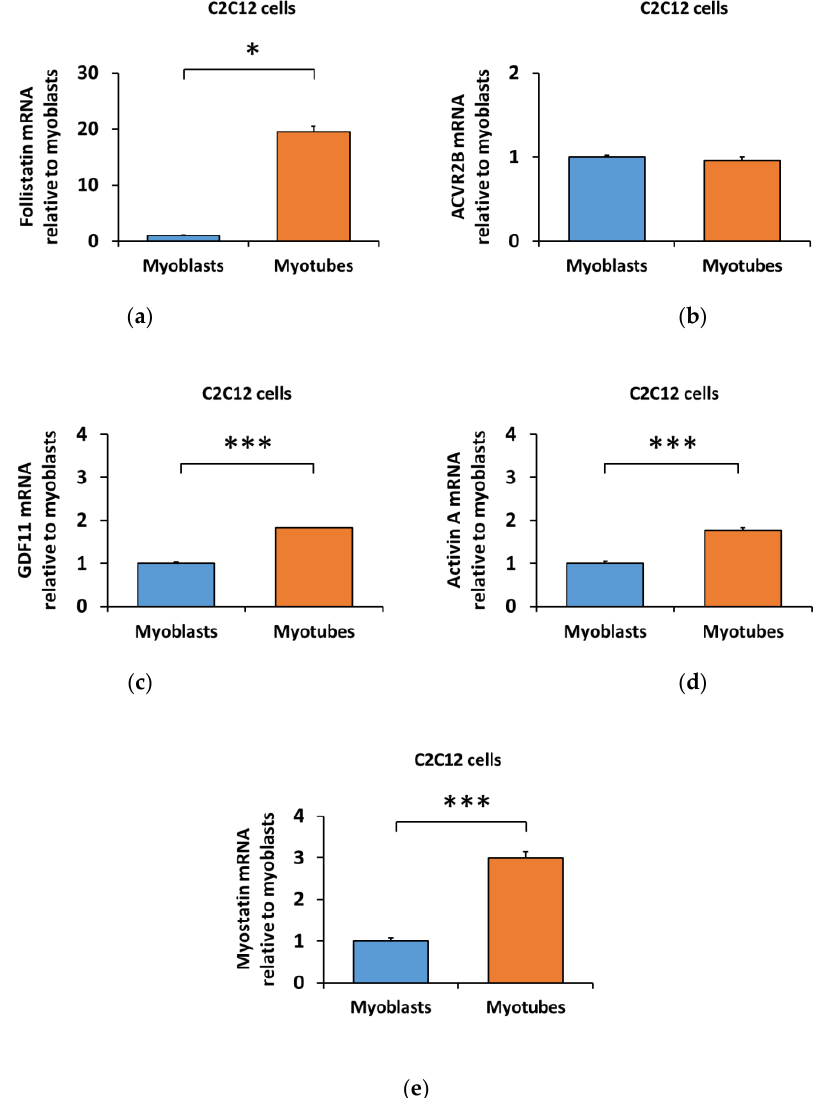
Figure 5. Differentiation of the C2C12 cells increased the mRNA level of ( a ) follistatin, while ( b ) ACVR2B remained unaltered. Of the ACVR2 ligands, ( c ) GDF11, ( d ) activin A, and ( e ) myostatin mRNAs were increased in myotubes in comparison to myoblasts. In the figures, the values are presented as normalized to myoblasts = 1. N = 3 per group. *, *** = p < 0.05 and p < 0.001, respectively.